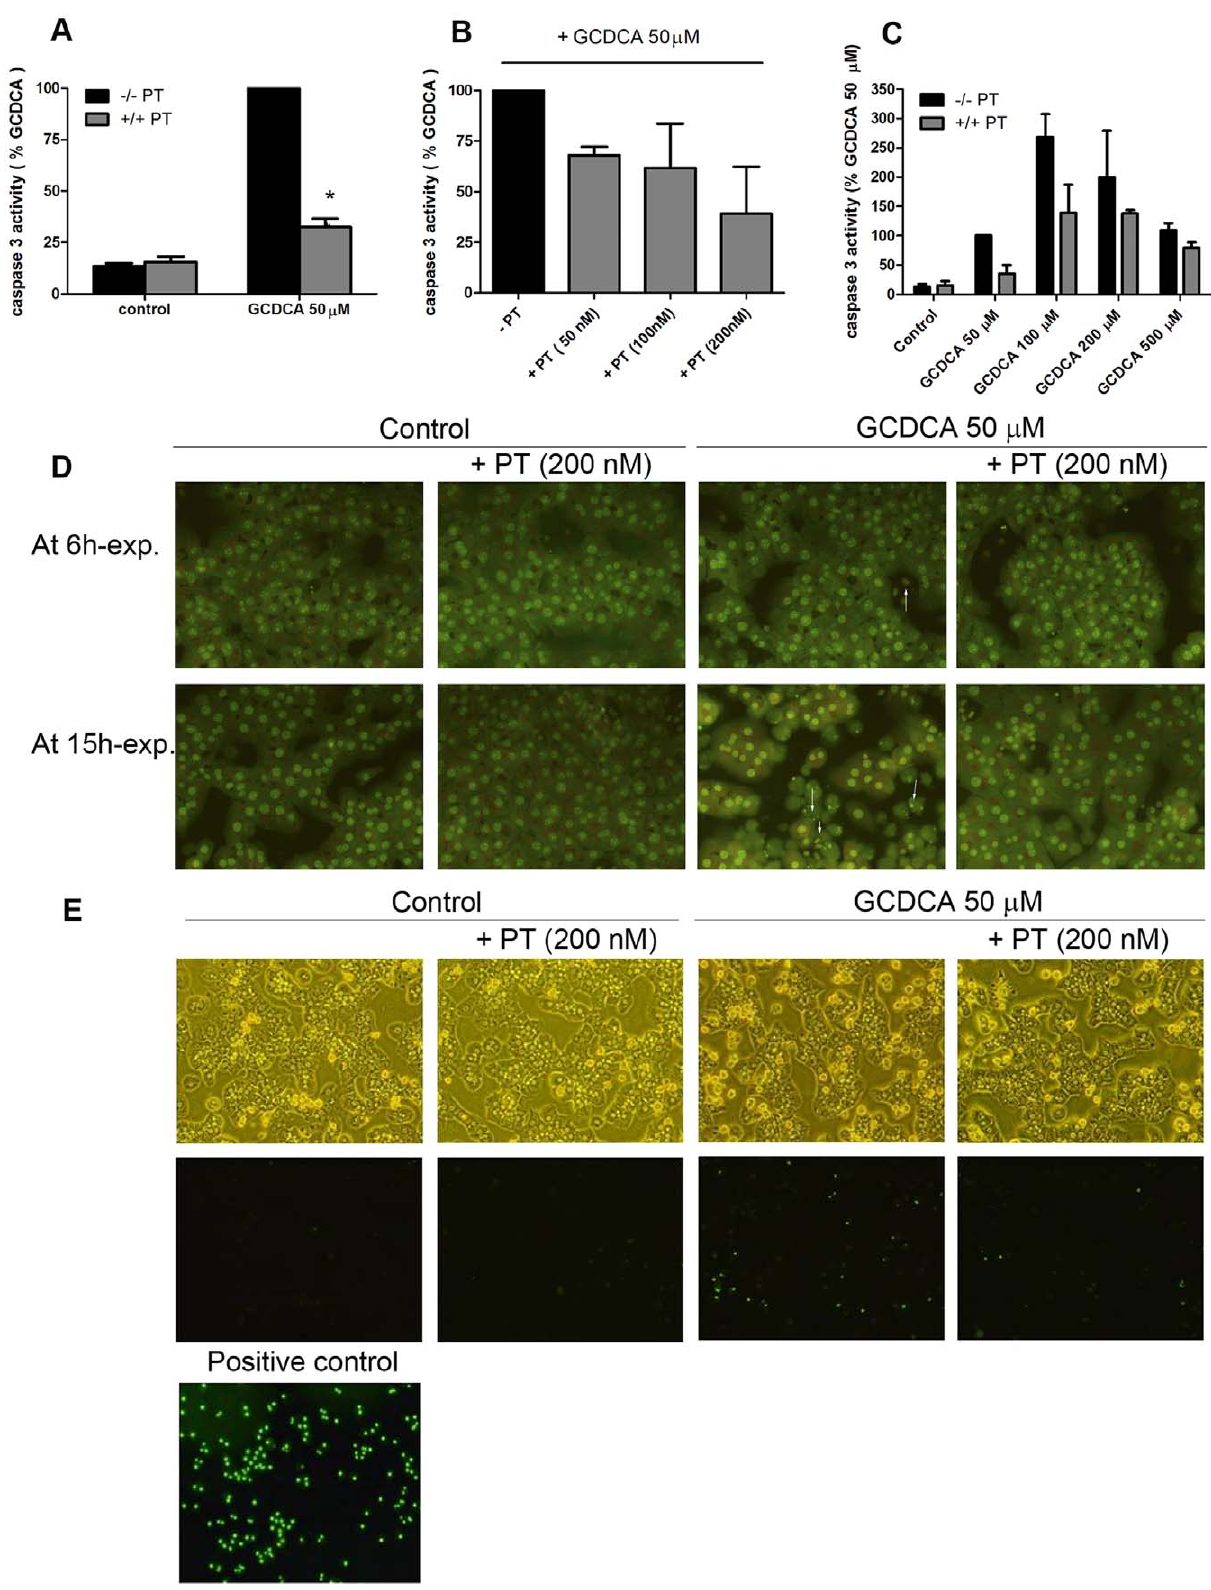
Figure 1. Pertussis toxin (PT) inhibits glycochenodeoxycholic acid (GCDCA)-induced caspase-3 activity and nuclear fragmentation. ( a ) Primary rat hepatocytes were treated for 4 hours with 50 m mol/L of GCDCA, 200 nmol/L of PT or a combination of both. PT was added 30 min prior to the addition of GCDCA. * P , 0.05 for GCDCA + PT vs. GCDCA alone. ( b ) Hepatocytes were treated with different concentrations of PT 30 min